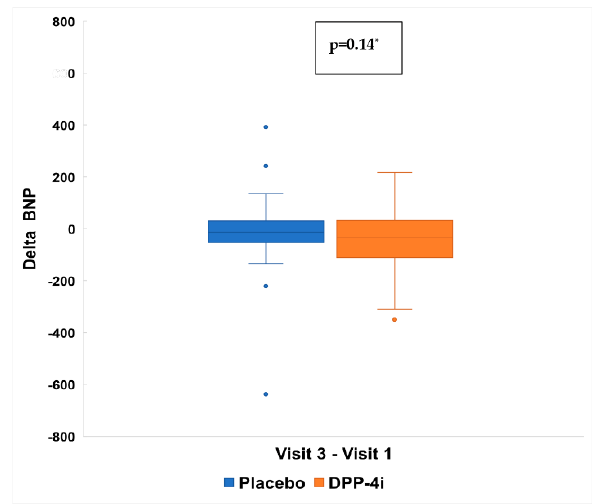
Figure 5. Changes in BNP( ∆ ) between baseline and 30 days. Visit 1:baseline. Visit 3: 30 ± 5 days. ∆ Visit 3—Visit 1: Placebo = − 13.00 ( − 50.00; 27.00); DPP-4i = − 36.00 ( − 110.000; 15.00). * Mann-Whitney test values expressed as